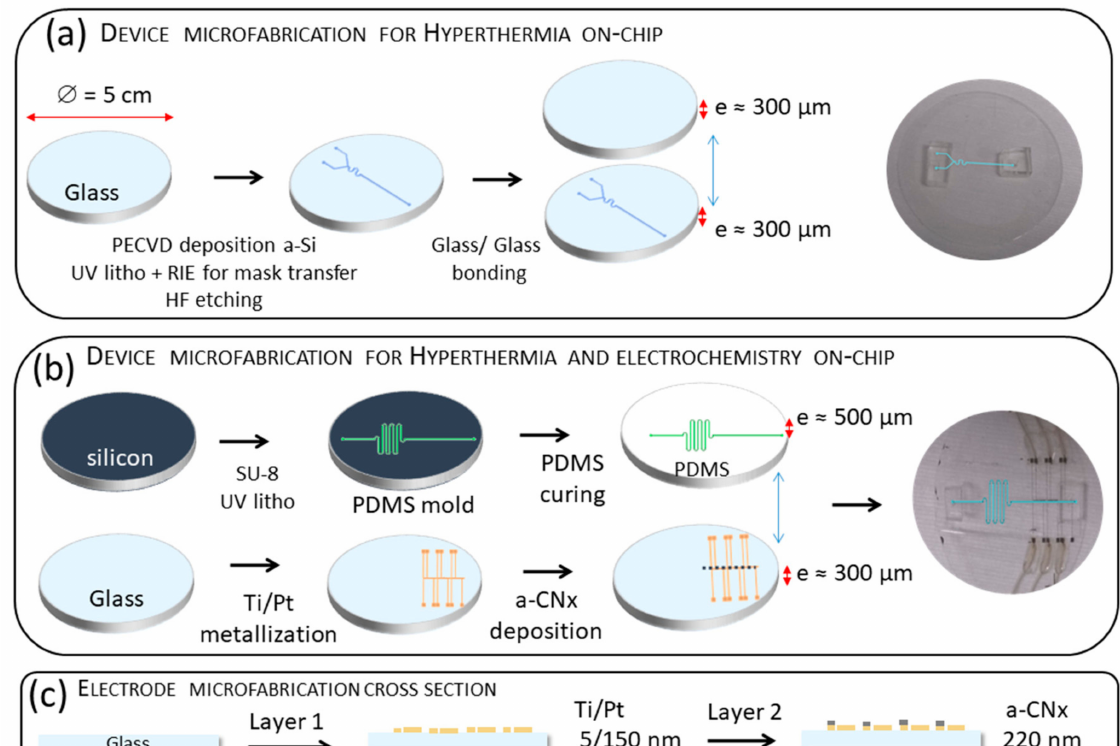
Figure 1. Schematic view of microfabrication key steps. ( a ) PDMS fabrication and bonding for on-chip hyperthermia. ( b ) Inverted optical lithography, Ti/Pt metallization and amorphous carbon nitride (aCNx) deposition by magnetron sputtering for on-chip electrochemistry. ( c ) Schematic cross section view of material layers deposition Ti/ Pt and a-CNx for counter-electrodes (CE) and working microelectrode (WE) networks, respectively. See Appendix B for more details on electrodes composition and